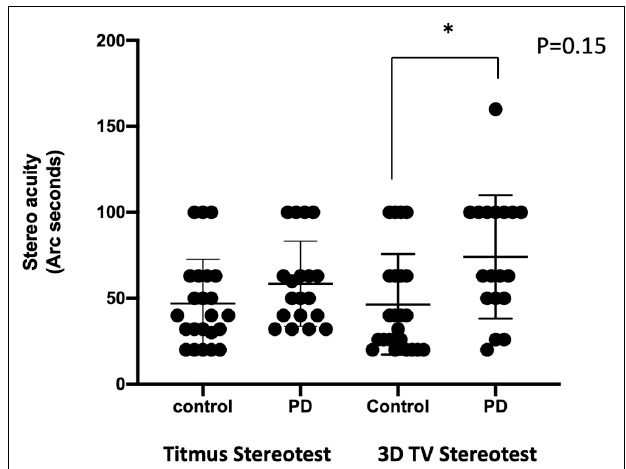
FIGURE 2 | Comparison of the stereo acuity using different methods. Stereo acuity (acuity in arc seconds) assessment with Titmus stereotest was shown on the left, and the 3D active shutter system was shown on the right. ∗ , p = 0.15, with Mann–Whitney U -test.